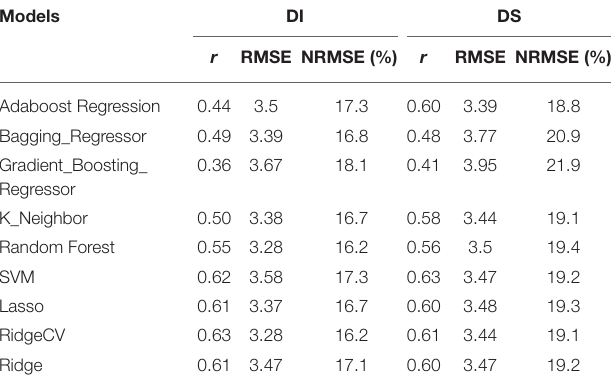
TABLE 4 | Model analysis of CC for vegetation index prediction at the heading